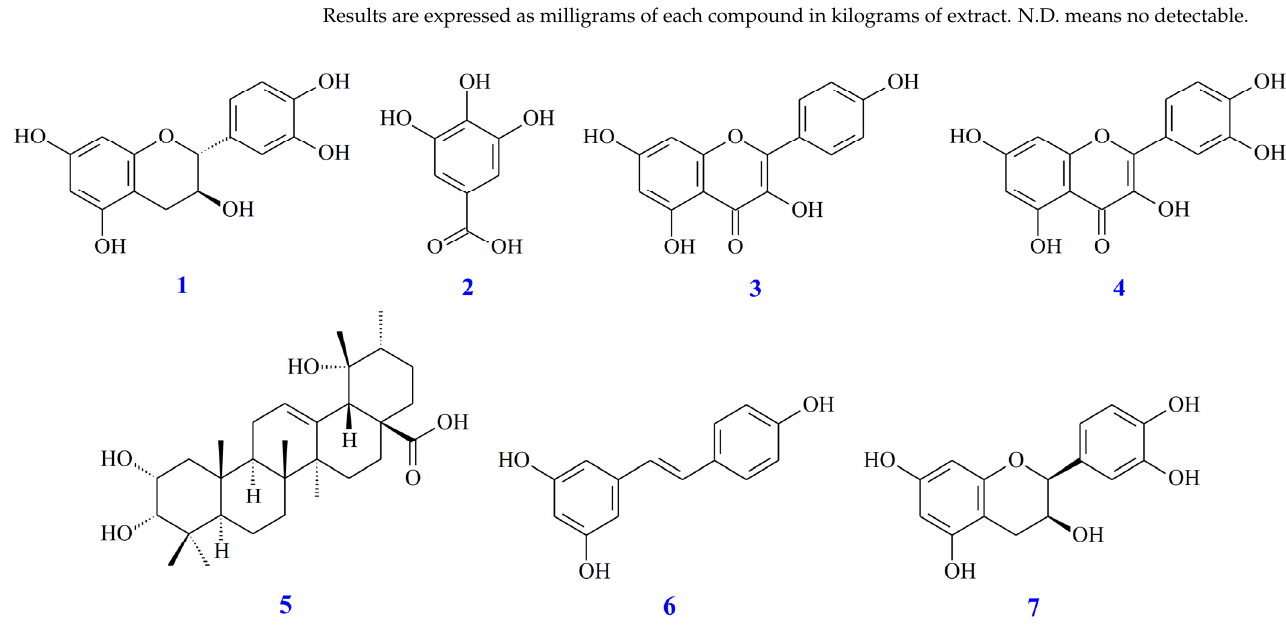
Table 5. Antioxidant effects of isolated compounds from Ampelopsis japonica measured with DPPH, ABTS, superoxide radical scavenging, and FRAP assays.